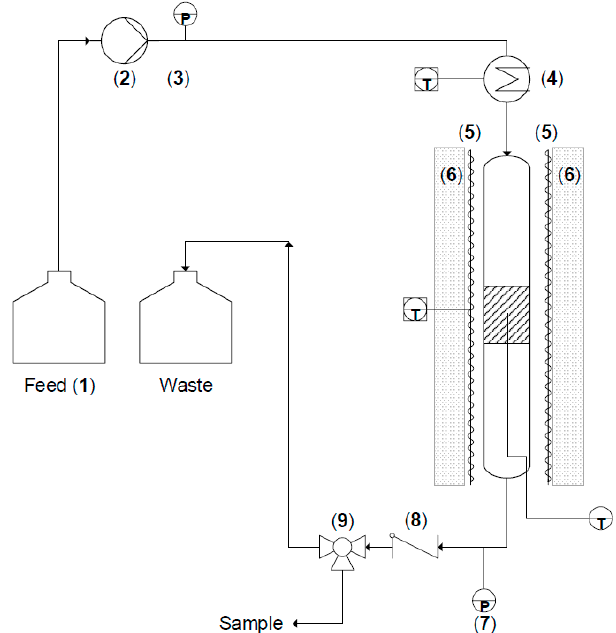
Figure 10. Schematic of the (LS)² reactor with the feed vessel (1), the positive displacement pump (2) with pulsation damper and pressure readout (3), the pre-heating (4), the reactor heating (5) and insulation (6), the outlet pressure gauge (7), and the check valve (8) and three-way valve (9) for drawing samples.